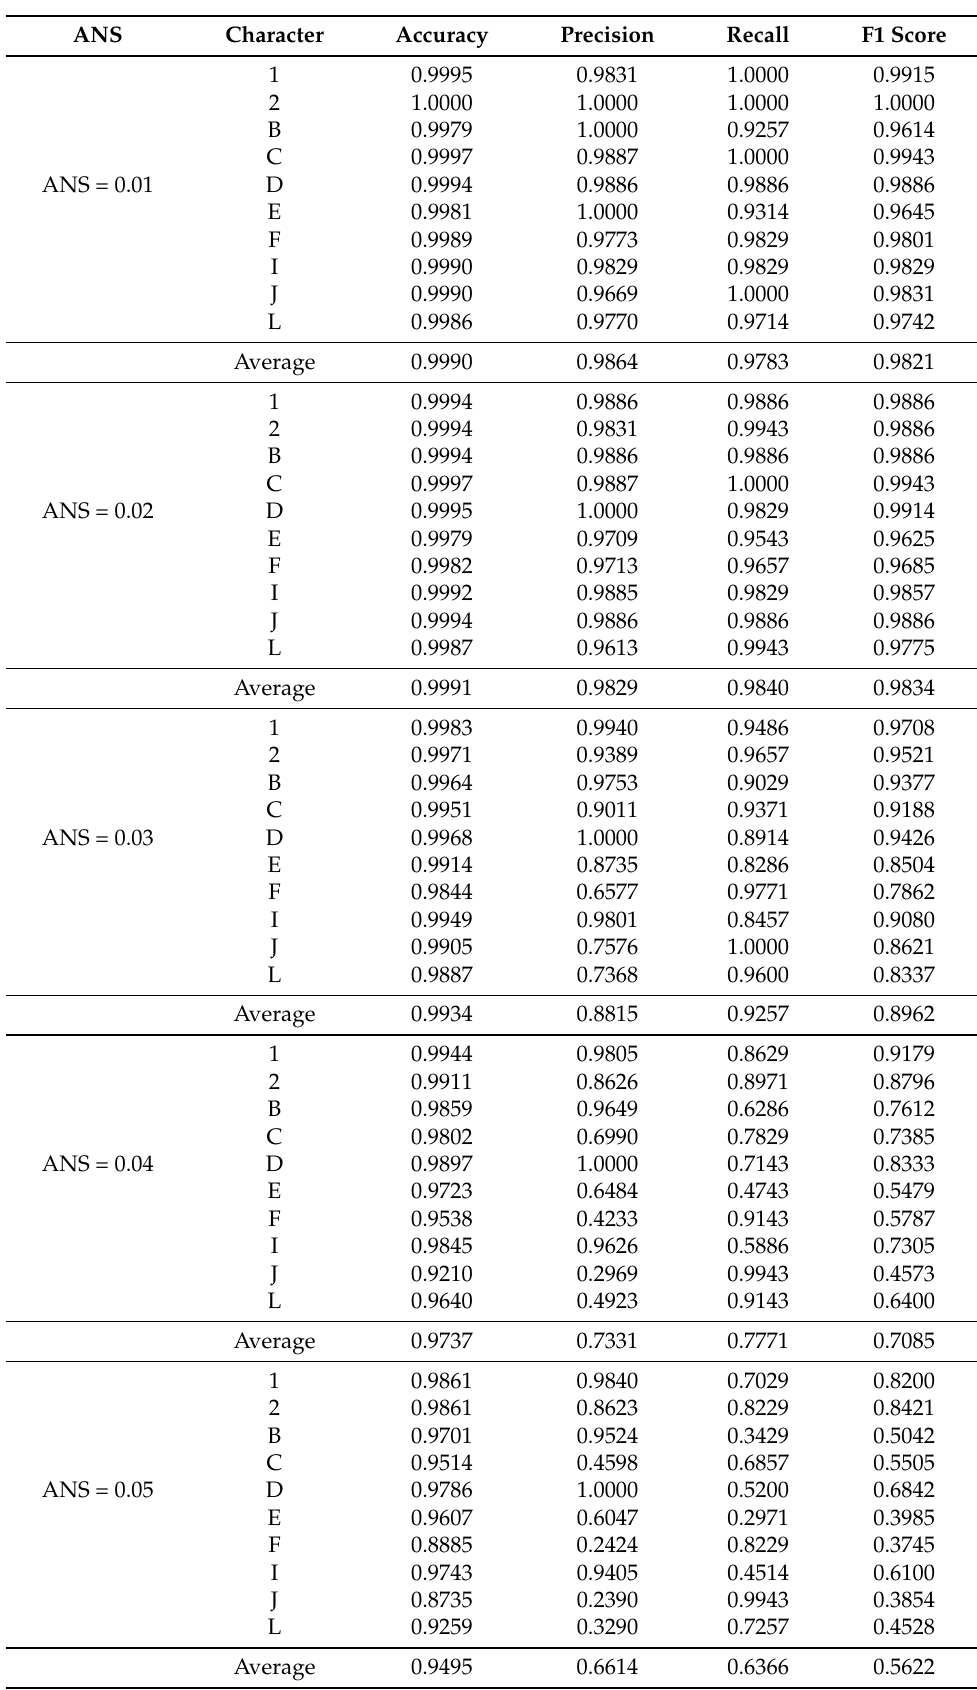
Table 5. Adversarial noise validation of the EfficientNet-B0 networks from selected